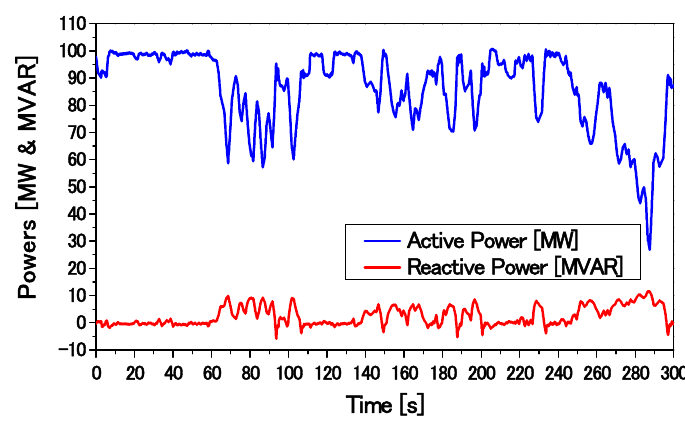
Figure 38. Total active and reactive power output at bus 12.